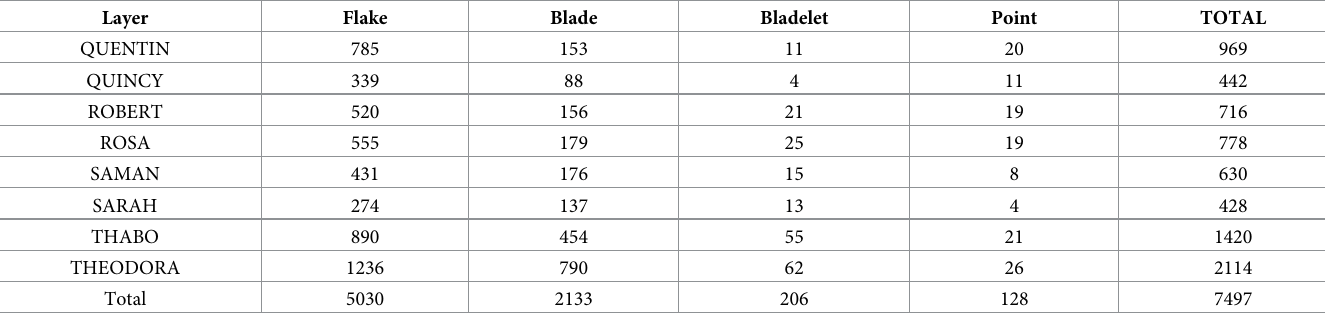
most marked and significant changes exist between the bottom (THEODORA-THABO) vs. Table 4. Distribution of blank types for lithic debitage > 30 mm (n) by layer for the Sibudu HP. Layer